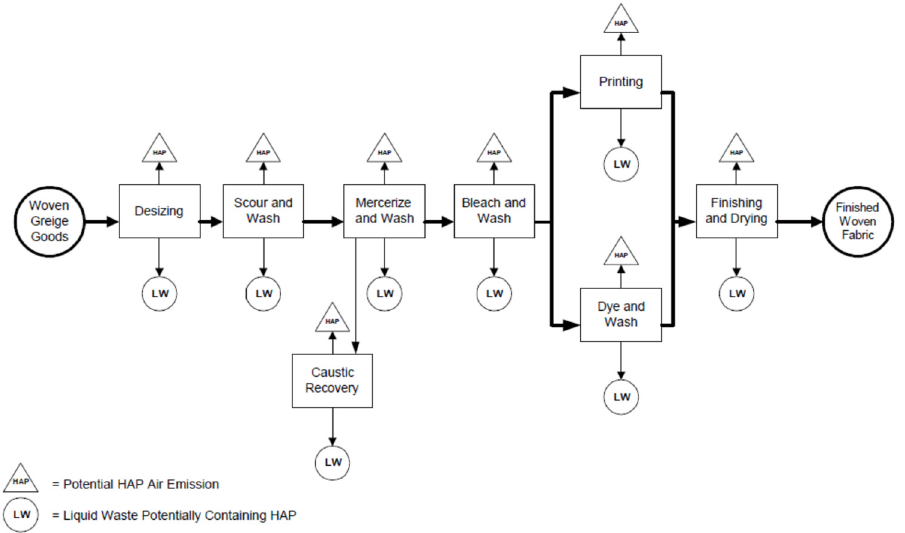
Figure 4. Schematic of typical woven fabric wet-processing operations [17].